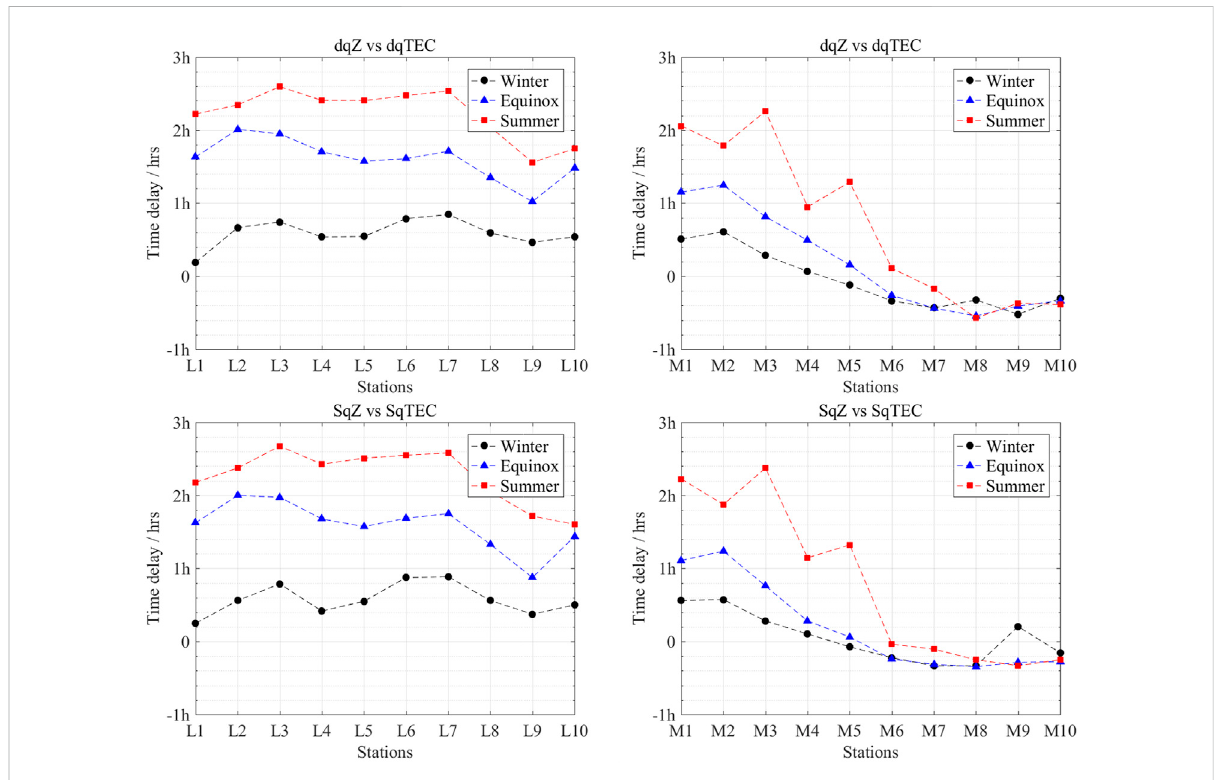
FIGURE 6 Comparison of average time delay in each Lloyd season.